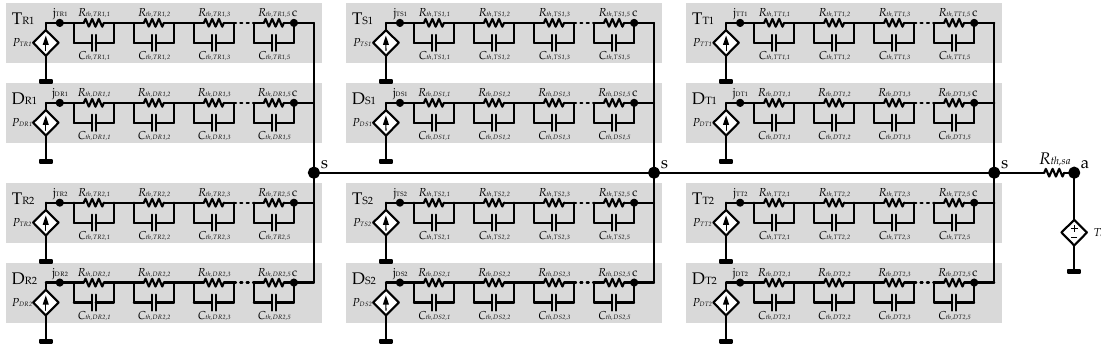
Figure 15. Equivalent thermal circuit of the two level three-phase inverter, where each semiconductor Foster circuit is marked with a grey area.